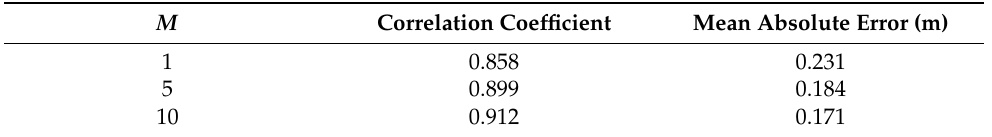
Table 3. Error statistics for 30 s radar predictions versus buoy measurements.